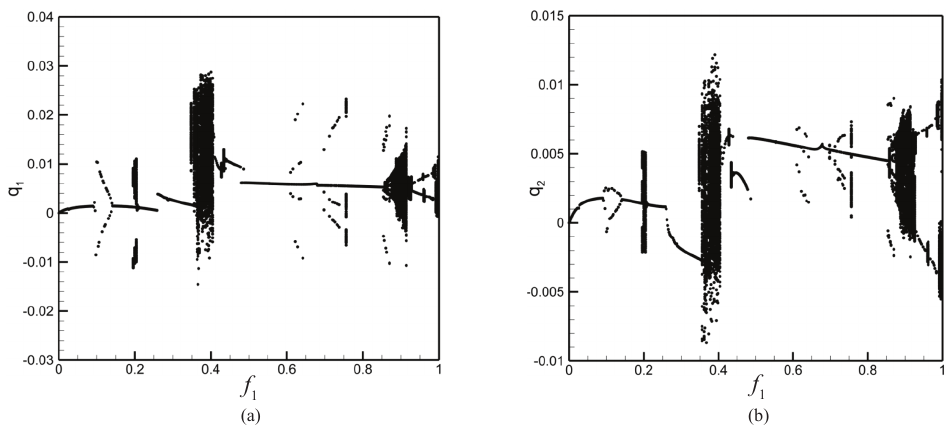
Fig. 10. Bifurcation diagrams of Poincaré points for increasing forcing amplitude on the system with c = 1 ,α = 5 and β = 1 .